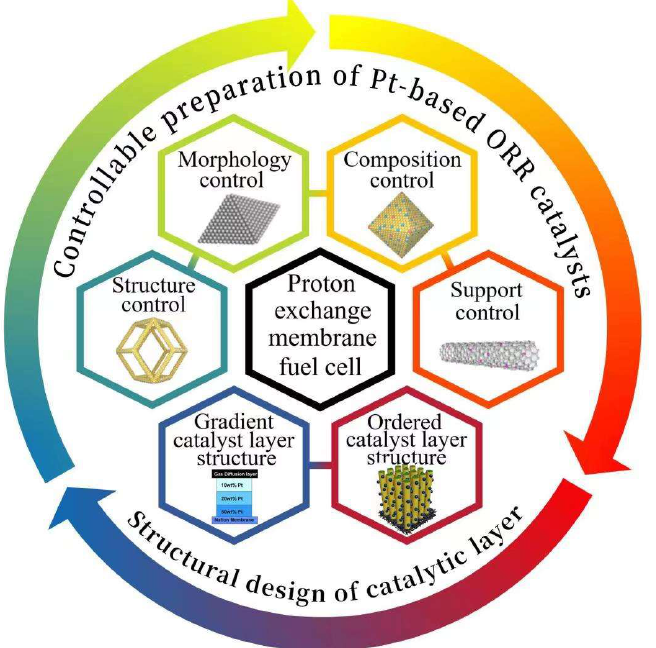
Figure 1. Overview framework of Pt-based oxygen reduction reaction catalysts in proton exchange membrane fuel cells.